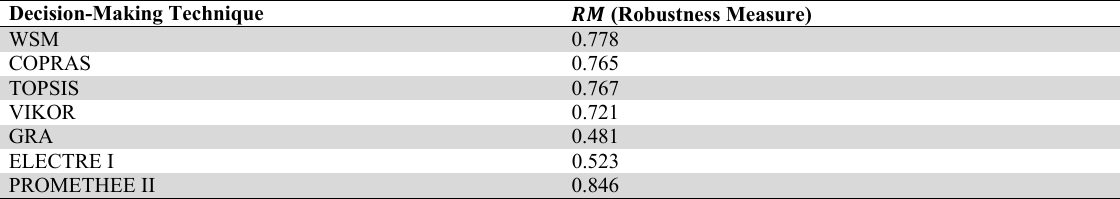
Robustness measure of multi-criteria decision making techniques Decision-Making Technique (cid:2174)(cid:2169) (Robustness